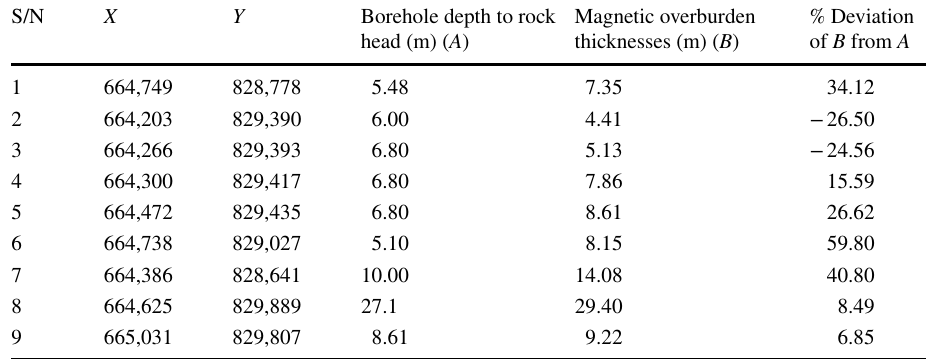
derived from borehole, magnetic overburden thicknesses and the percentage deviation